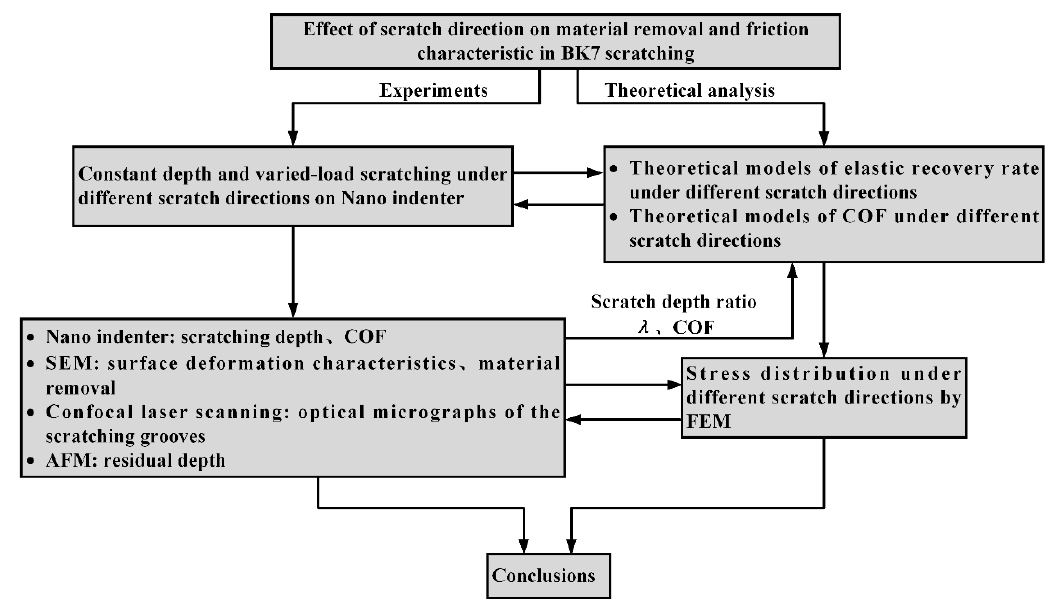
Figure 3. The schematic flow chart for study the effects of scratch directions.